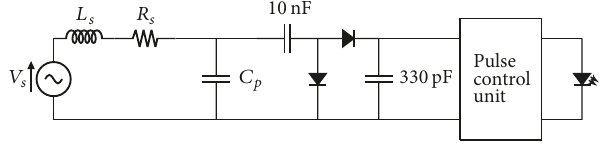
Figure 6: The circuit diagram of the receiver.